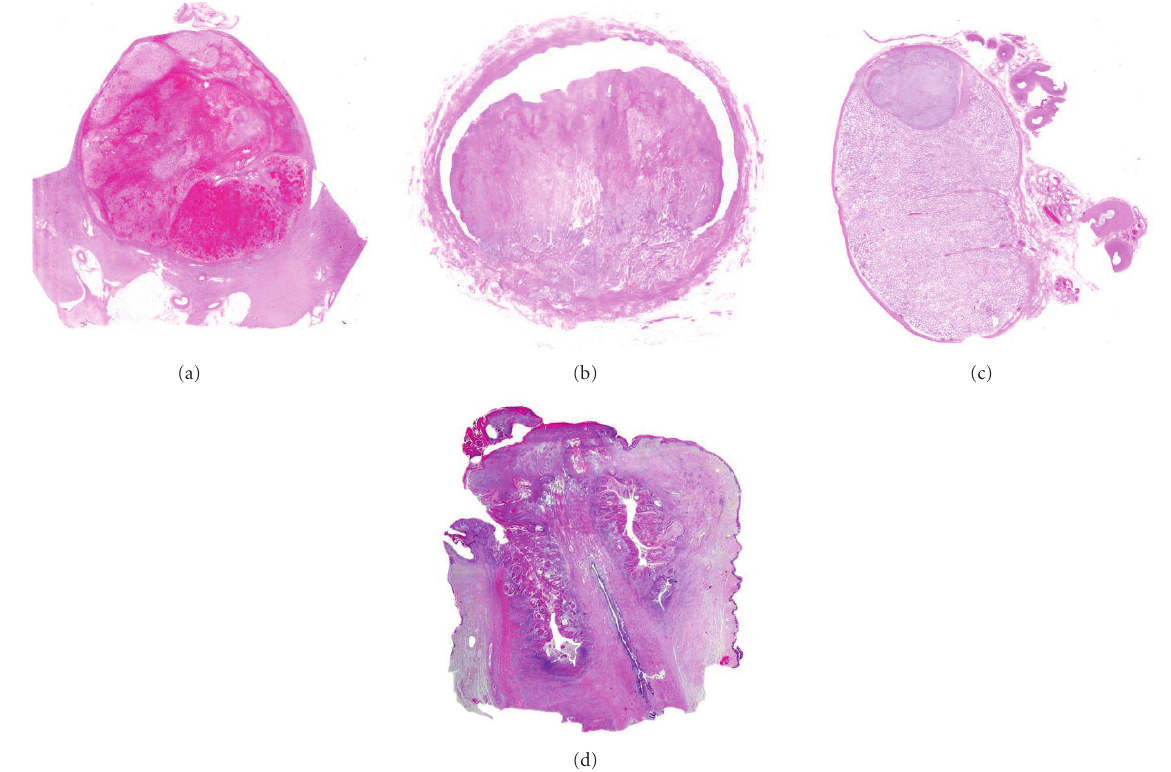
Figure 2: Examples of large-format histology of a kidney with clear cell renal cell carcinoma (a), of a urinary bladder with urothelial carcinoma (b), of a testis with seminoma (c) and a penis with squamous cell carcinoma